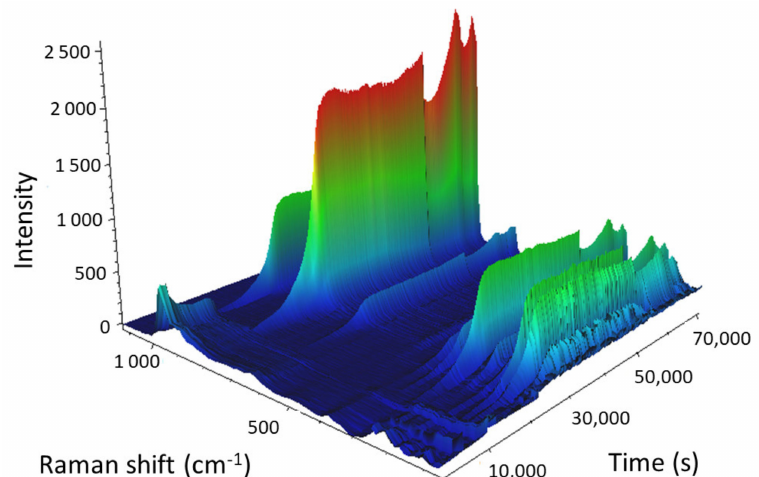
Figure 12. 3D view of the calcination of the Mo-supported mesoporous silica catalyst with a Mo content of 24 wt%. Heating: starting temperature 25 ◦ C; temperature gradient 1 ◦ C / min; end temperature 500 ◦ C (in 28,738 s). Isotherm for 4 h (43,072 s). Cooling: start temperature 500 ◦ C; temperature ramp 1 ◦ C / min; end temperature 50 ◦ C (70,383